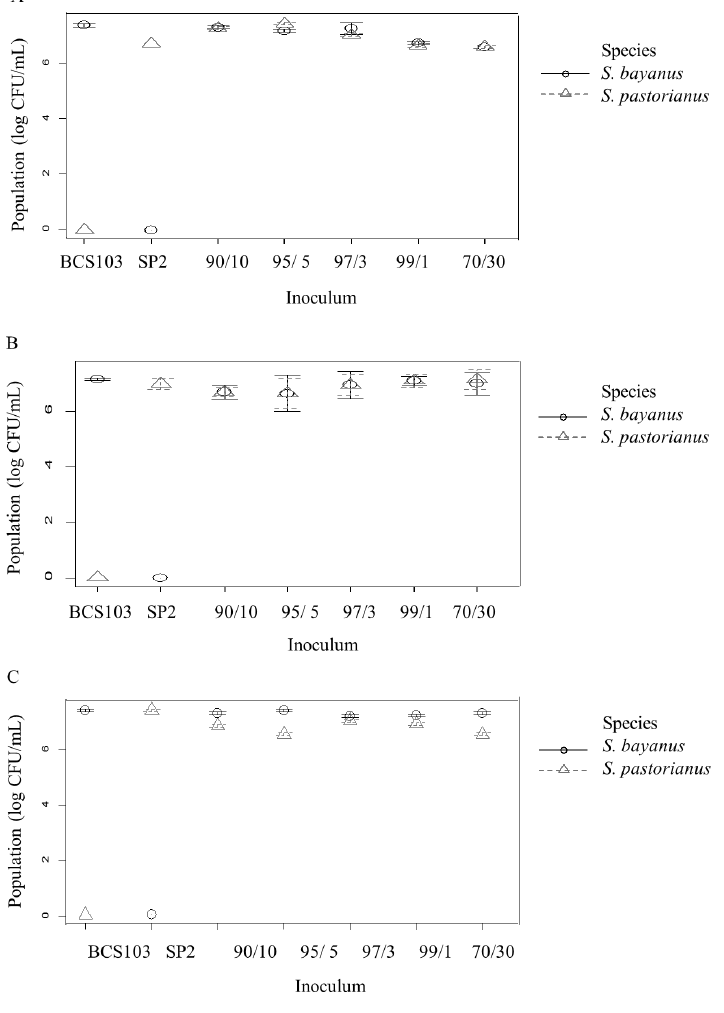
Figure 2. Evolution of S. bayanus BCS103 and S. pastorianus SP2 populations (in log CFU/mL) during alcoholic fermentation of Sauvignon Blanc must after 48 h ( A ), 2/3 of the process ( B ) and at the end of fermentation ( C ). The must was fermented under different inoculation schemes using S. bayanus BCS103 (BCS103) and S. pastorianus SP2 (SP2) as monoculture ς as well as co-inoculation of S. pastorianus SP2 and S. bayanus BCS103 at a ratio of 90/10, 95/5, 97/3, 99/1 and 70/30.